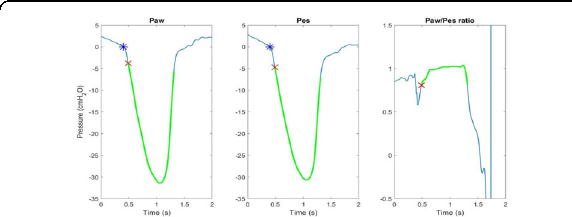
Fig. 1 (abstract 001060). Airway pressure (Paw), esophageal pressure (Pes) and the Paw/Pes ratio during one expiratory hold. The